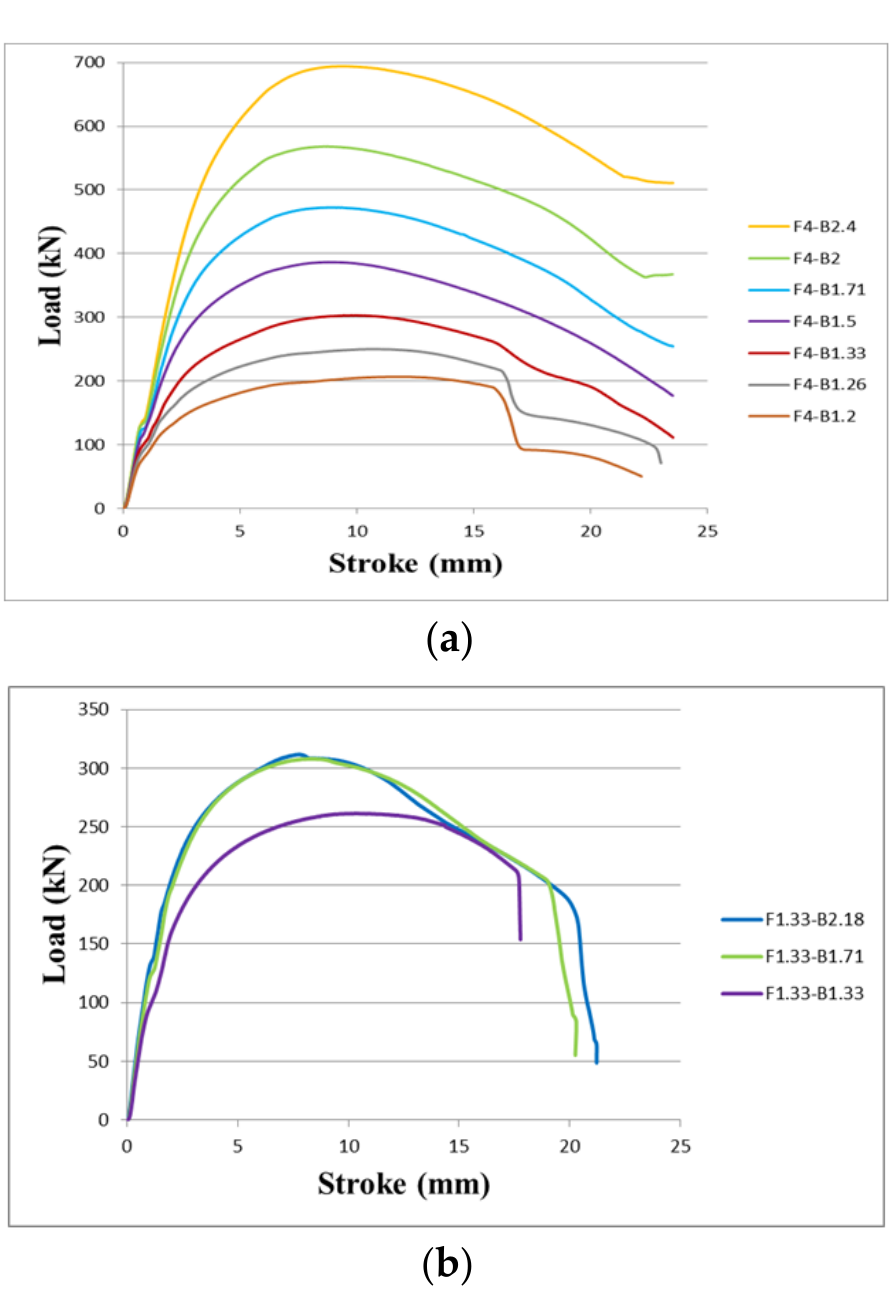
Figure 6. Forming load-stroke curves for ( a ) FER fixed at 4, and ( b ) FER fixed at 1.33.